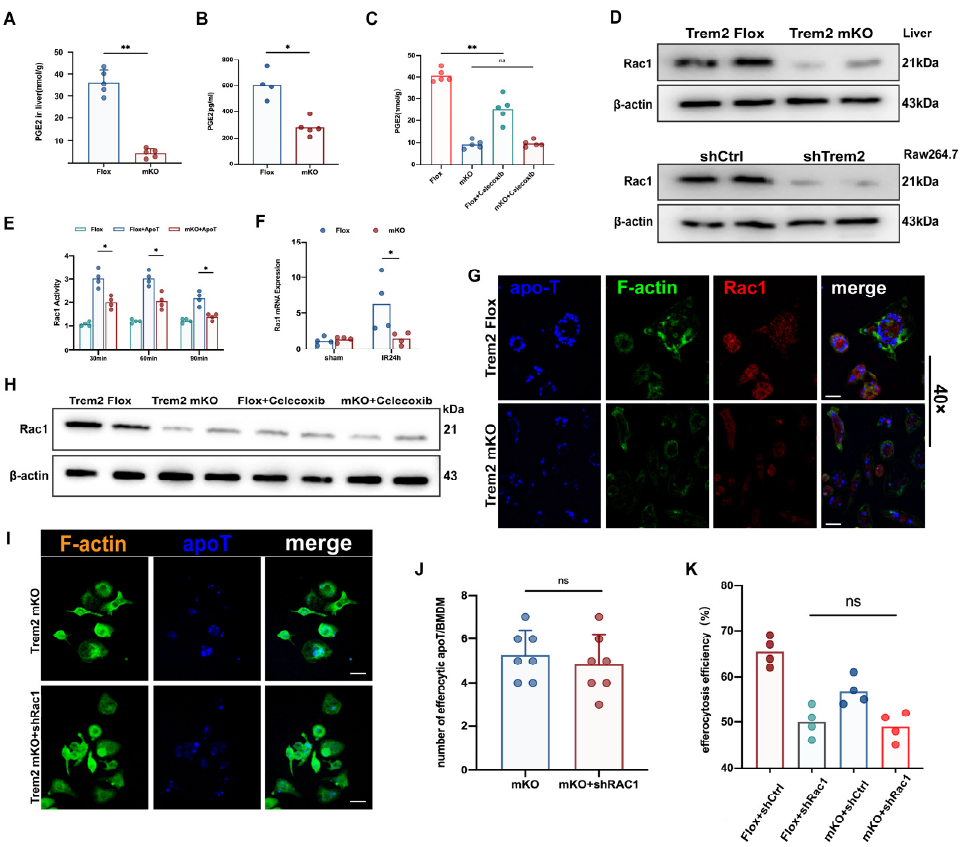
Figure 7. Trem2 conducts Rac1 signal in phagocytes through the COX2/PGE2 axis. ( A ) the relative abundance of PGE2 in the liver of Trem2 FL/FL or Trem2 mKO at IR24h was detected by mass spectrometry (nmol/g, n = 5, ** p < 0.01); ( B ) The PGE2 content in the supernatant of efferocytosis or ( C ) the liver of mice injected with Trem2 FL/FL or Trem2 mKO intraperitoneally with celecoxib for 24 h was de- tected ( n = 4–5, ns = Not Significant,* p < 0.05, ** p < 0.01); ( D ) The protein expression of Rac1 in Trem2 FL/FL or Trem2 mKO livers of IR24h and Rac1 in RAW264.7 of Lenti-shCtr1 or Lenti-shTrem2 sub- jected to efferocytosis were detected by Western blot; ( E , G ) the activity of Rac1 in Trem2 FL/FL or Trem2 mKO BMDMs at different efferocytosis times (scale bars = 100 μ m) and ( F ) the expression of Rac1 in the liver at IR24h ( n = 4, * p < 0.05); ( H ) Western blot was used to detect the expression of Rac1 in the livers of mice treated with Trem2 FL/FL or Trem2 mKO injected intraperitoneally with celecoxib for 24 h; ( I – K ) Identification of phagocytic efficiency and F-actin remodeling when BMDMs with Trem2 mKO or Trem2 mKO + shRac1 exercised the efferocytosis program by immunofluo- rescence (scale bars = 50 μ m, ns = Not Significant). 3. Discussion Our study revealed that myeloid Trem2 might play a bidirectional role at different stages of inflammation in response to different ligands and mediators. In the induction phase of inflammation, deletion of myeloid Trem2 inhibits the activation of iNOS, MCP- 1, and CXCL1/2 (Figure 2), which in turn leads to a reduction in the recruitment of inflam- matory monocytes and S100A9+ neutrophils and production of ROS. Notably, the deletion of myeloid Trem2 also affected the reprogramming of inflammatory monocytes from Ly6C hi CX3CR1 low to reparative macrophages from Ly6C low CX3CR1 hi and impaired the ef- ficiency of efferocytosis by inhibiting the recognition of apoptotic cells and preventing macrophage actin polymerization driven by Rac1, thus delaying the inflammatory repair of liver IR. In summary, the absence of myeloid Trem2 attenuates the degree of induction of liver injury but simultaneously slightly impairs the timely resolution of the IR liver. In recent years, the core role of myeloid cells in various pathological stress processes has gradually been recognized. Trem2, a transmembrane receptor of the immunoglobulin